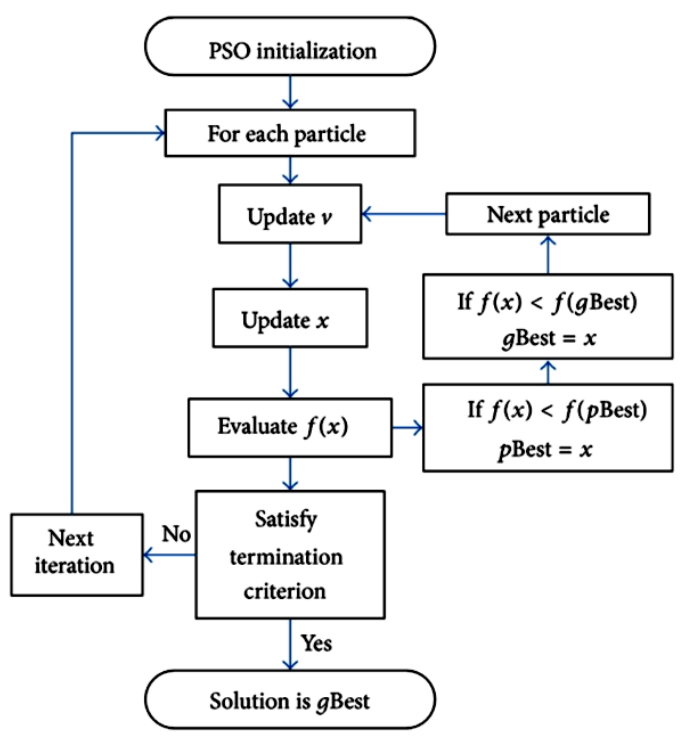
Figure 1. Particle swarm optimization (PSO) flowchart.